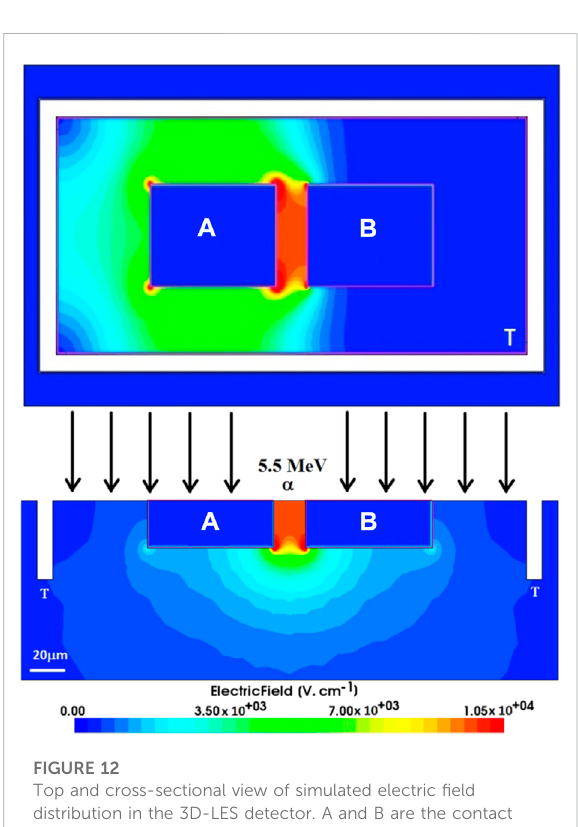
FIGURE 12 Top and cross-sectional view of simulated electric fi eld distribution in the 3D-LES detector. A and B are the contact electrodes while T indicates the isolation trench (white region). Source: